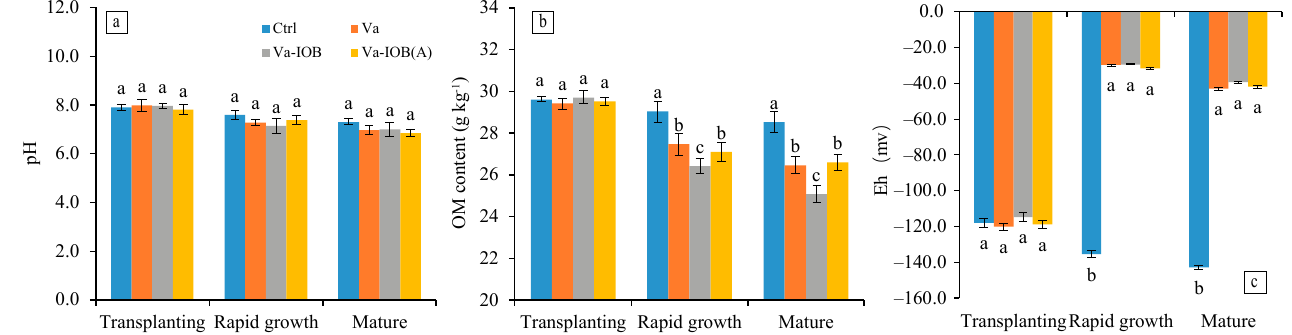
Figure 2. ( a ) pH, ( b ) organic matter (OM) content, and ( c ) redox potential (Eh) trends in sediments under different treatments during V. natans growth. Values are means ± standard deviation. For each stage, different lowercase letters above or below bars indicate significant differences at the 0.05 significance level by Tukey’s